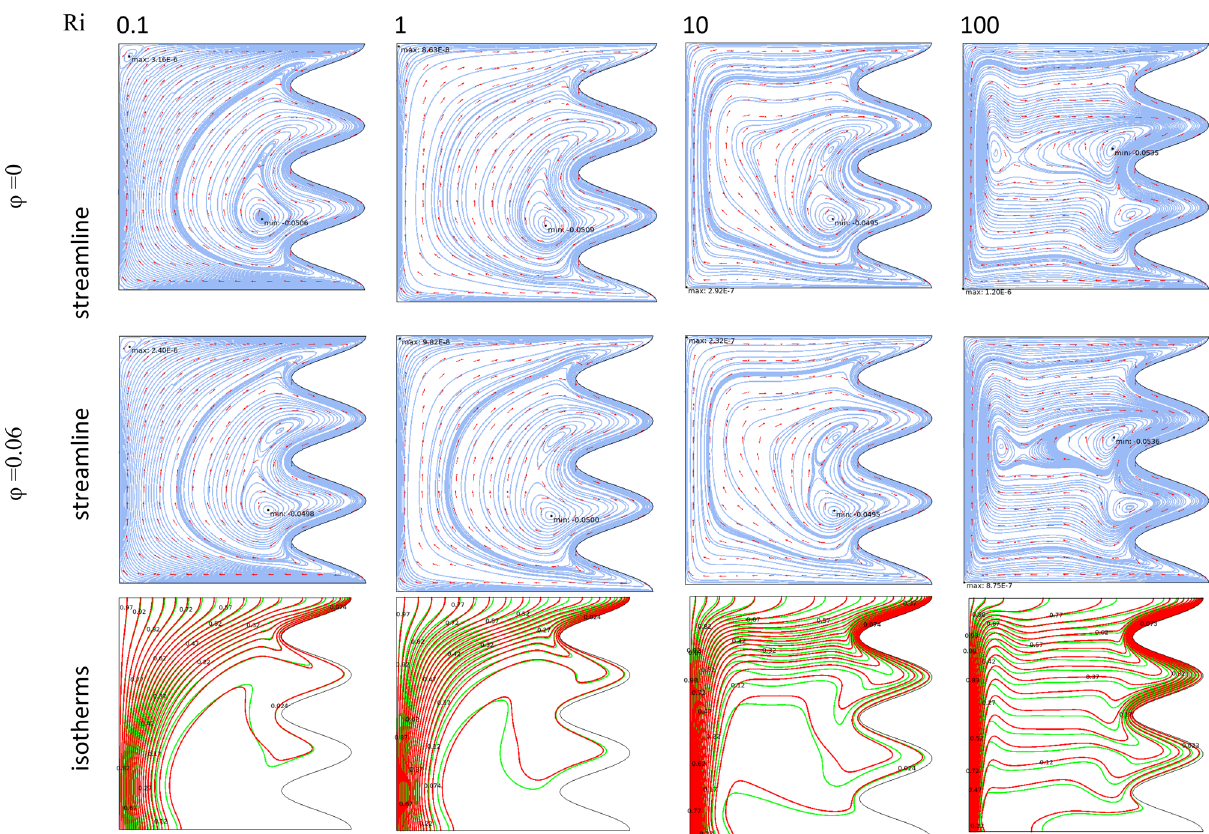
Figure 8. Streamlines an isotherms (Red line at φ = 0.06, green line at φ = 0) when Re = 100, Da = 1e−2, λ = 5, A = 0.15, Ha = 25, γ = 45) for Case